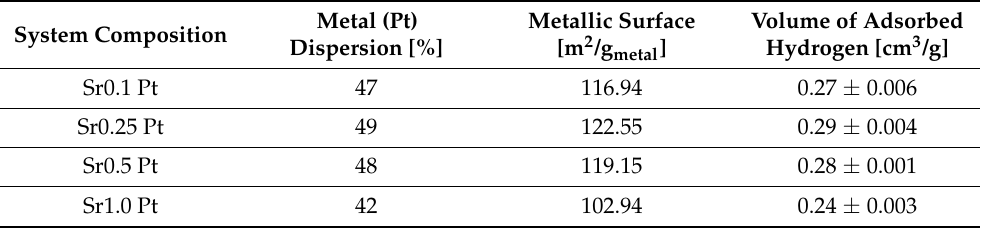
Table 2. Platinum dispersion, surface area, and volume of adsorbed hydrogen of the Pt/Al 2 O 3 - SrCO 3 systems.